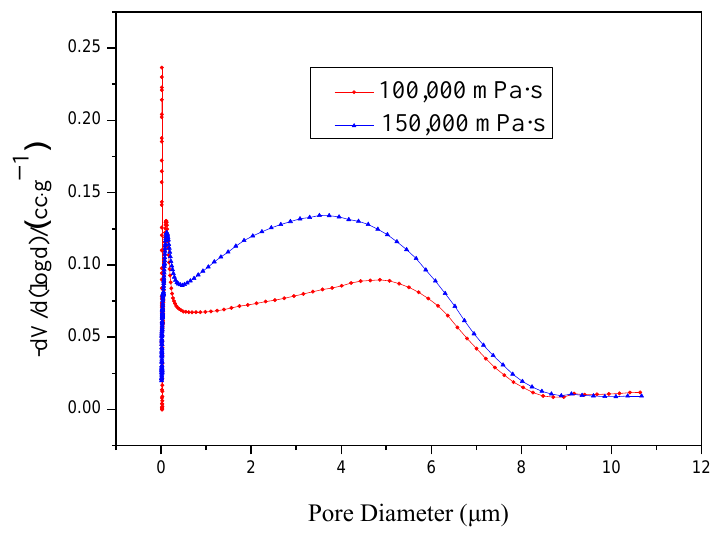
Figure 11. Pore structure of the mortar with 0.3% content HPMC.